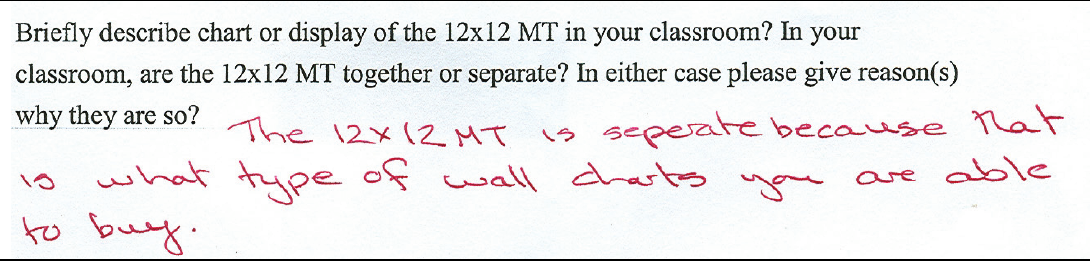
Figure 3 : A teacher’s explanation for the 12×12 multiplication tables (MT) in classrooms